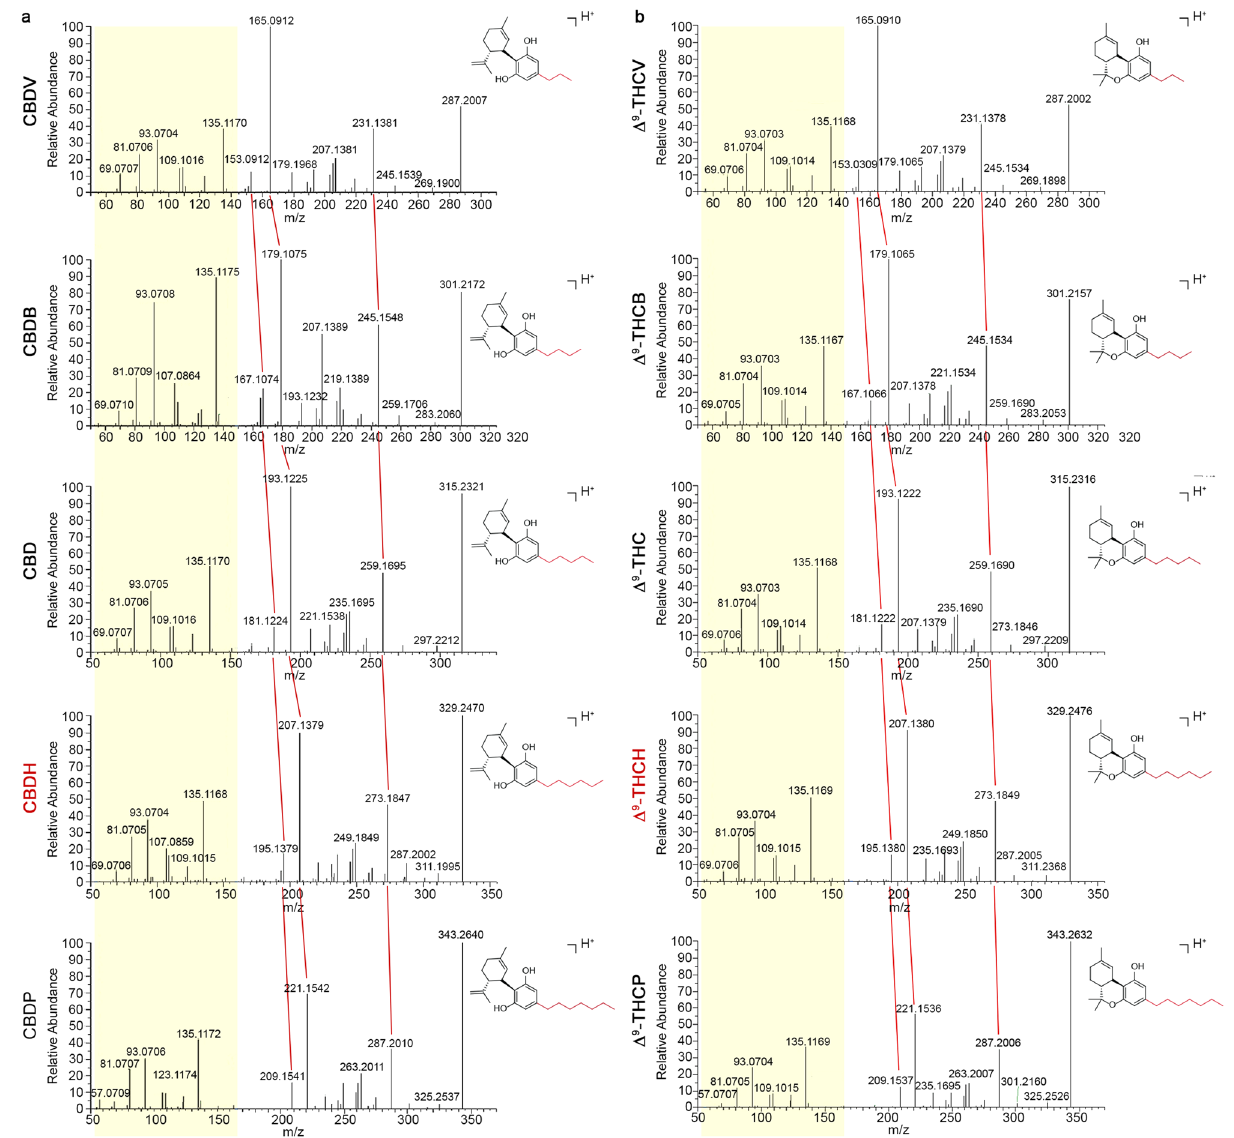
Figure 2. MS/MS spectra library of CBD and Δ 9 -THC homologs by UHPLC-HESI-Orbitrap. Comparison of the high-resolution fragmentation spectra in positive (ESI+) mode for CBD (panel A ) and Δ 9 -THC (panel B ) homologs. The pale-yellow box point out the constant terpenic portion. The red lines highlight the shift of some fragments corresponding to the loss of a methylene portion (CH 2 , m/z = 14) moving from CBDP (or Δ 9 -THCP) to CBDV (or Δ 9